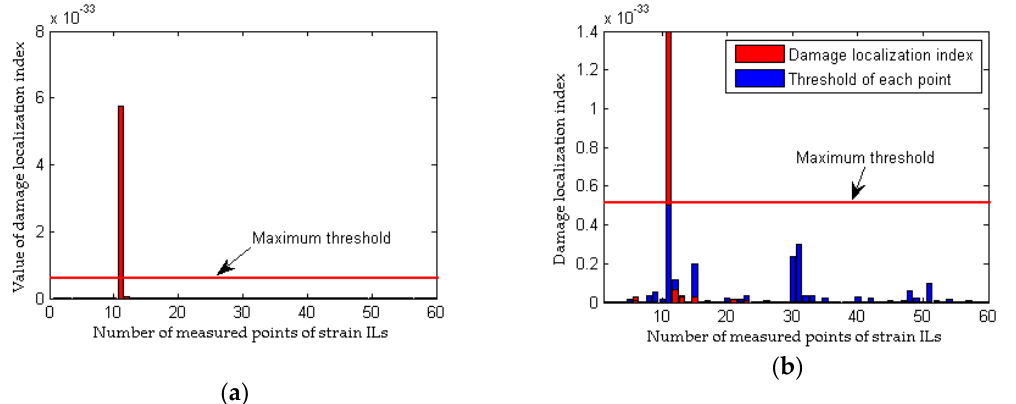
Figure 5. Results of the proposed method without the effects of measurement noise (for a single damaged element): ( a ) results of the proposed method for case 2; ( b ) detailed magnification of the results of the proposed method for case 2.